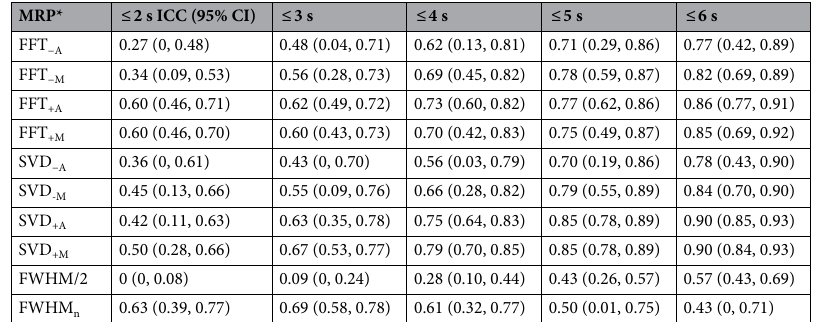
Table 2. ICC agreement analysis between Tmax/FWHM and TTP using the normalized delay time areas at thresholds of 2, 3, 4, 5, and 6 s. * MRP stands for the estimated MR perfusion parameters Tmax and FWHM. Tmax estimated by different deconvolution methods are noted with FFT, SVD with ( +) and without (−) GVM preprocessing; the characters ‘A’ and ‘M’ stand for the average and median of Tmax estimates derived from the top three AIFs respectively.